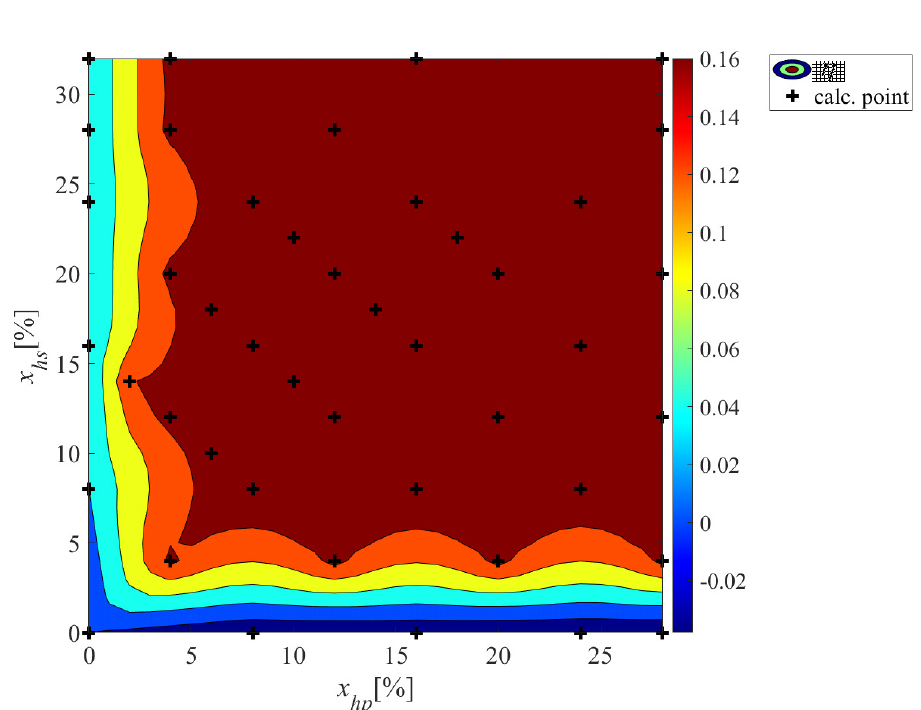
Figure 6. Ice volume reduction η . The plus symbol represents a single simulation. Second, the drag coefficient of the airfoil is evaluated. Figure 7 shows the drag coefficient normalized by the coefficient of the clean airfoil, C ∗ . Because C ∗ is more higher d d than one, the drag increases for all cases. The maximum C ∗ is observed at x hs = 4 and d x hp = 4. Roughly speaking, C ∗ is dependent on x hs rather than x hp : C ∗ rapidly decreases d d as x hs increases, while it almost remains unchanged as x hp increases.